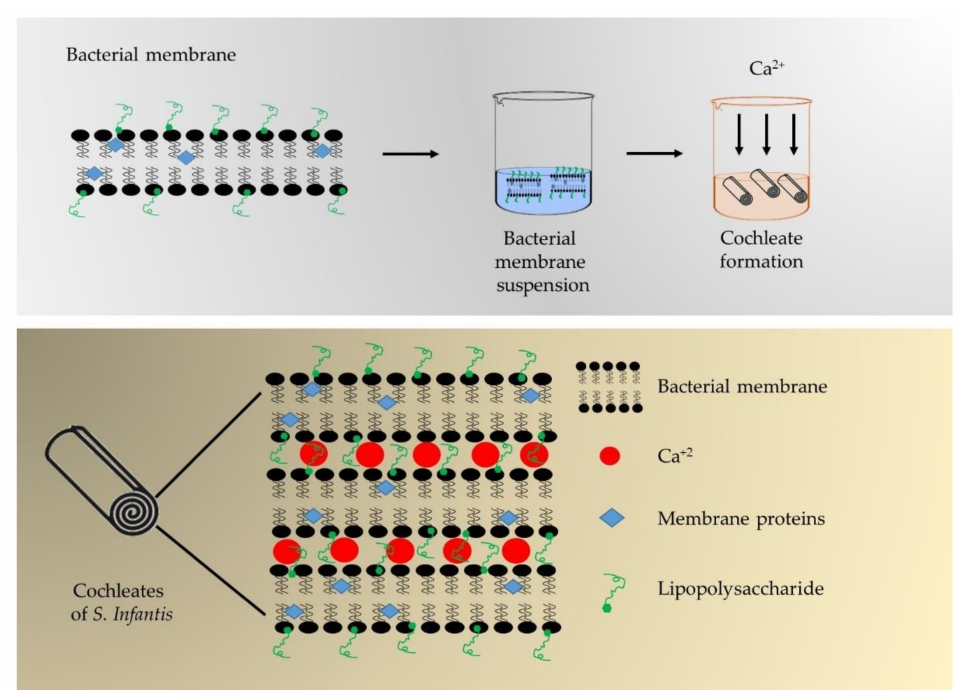
Figure 1. Simplified scheme of the procedure for the production of cochleates from S. Infantis and a graphic representation of the cochleates